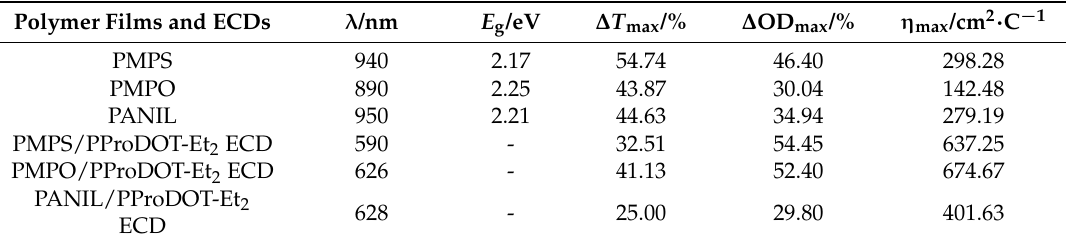
Table 5. Comparisons of the ∆ T max and η max for various polymer films and ECDs.